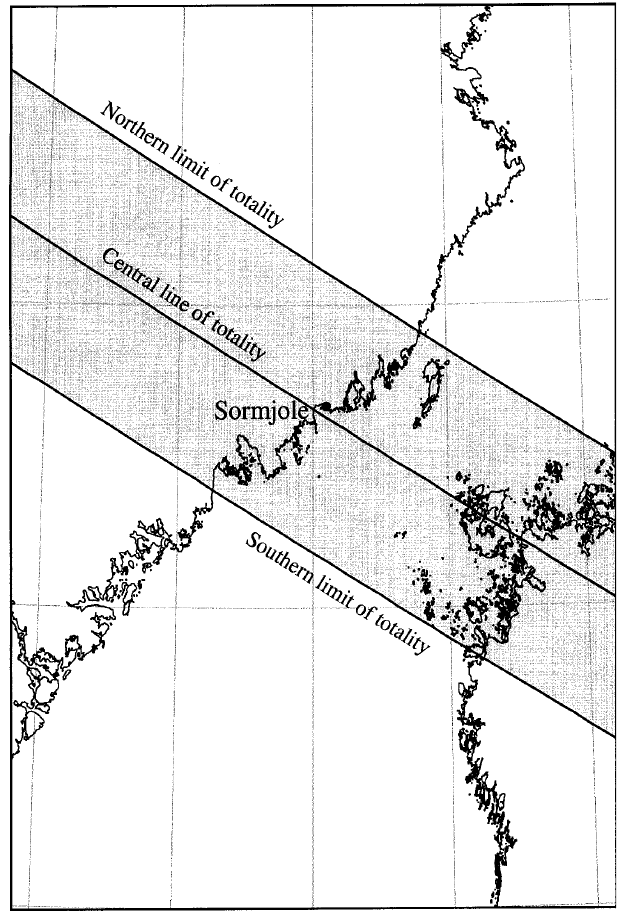
Fig. 4. The zone of totality at an altitude of 100 km across Sweden in the region of the observation point at So¨ rmjo¨ le during the eclipse of 9 July, 1945. So¨ rmjo¨ le lay very near the centre line, where totality lasted 1 min